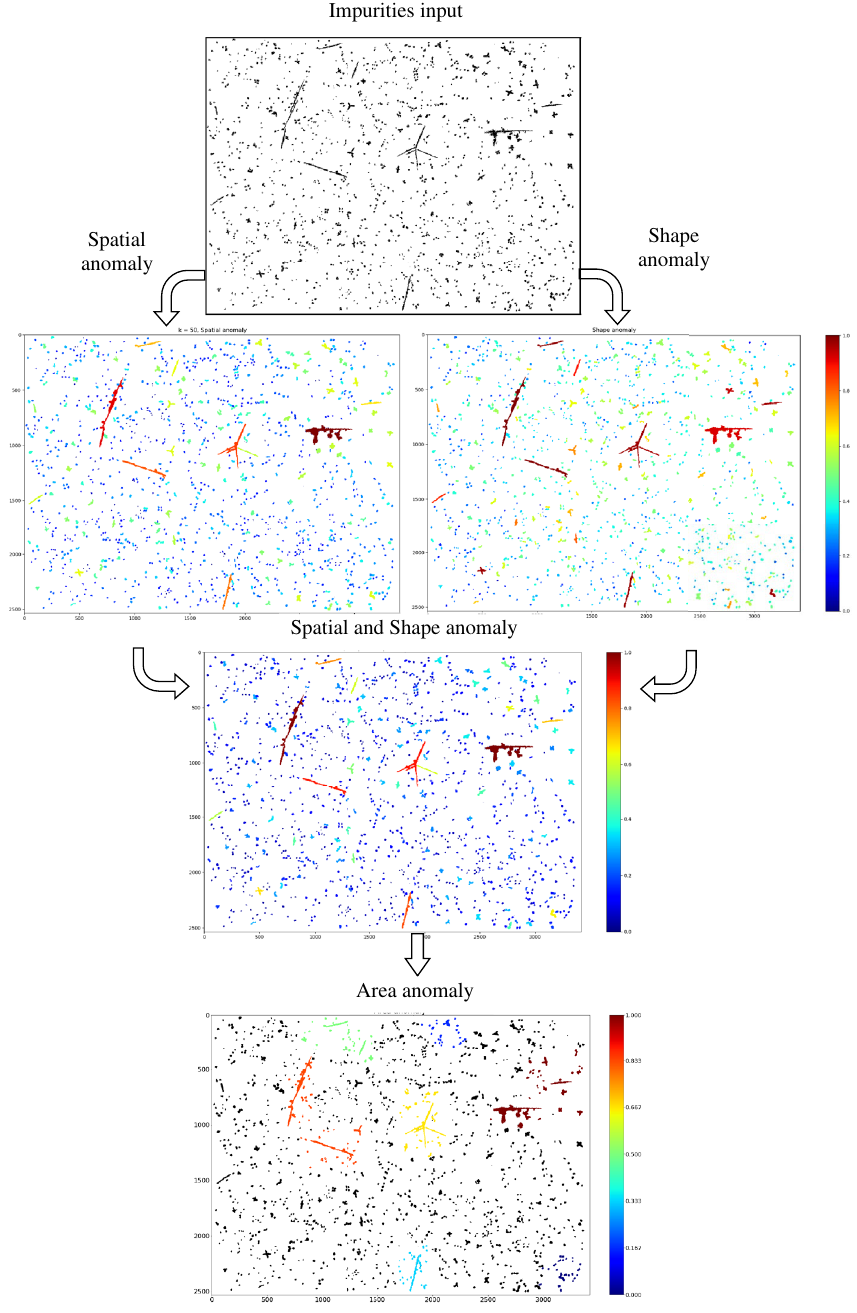
Figure 2. Proposed anomaly detection